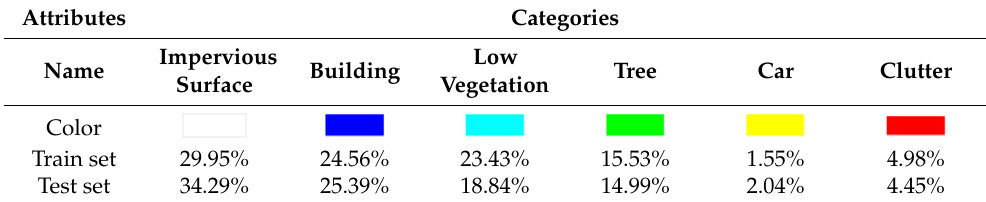
Table 2. The detailed information of Potsdam for experiments.